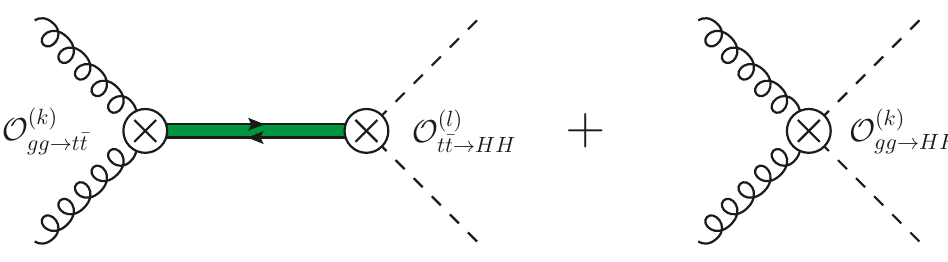
Figure 5 . Graphical representation of the terms in the master formula (3.1). The diagram on the left (right) corresponds to the ‘resonant’ (’non-resonant’) part of the amplitude. The shaded area indicates that Coulomb exchanges between the top quark pair are